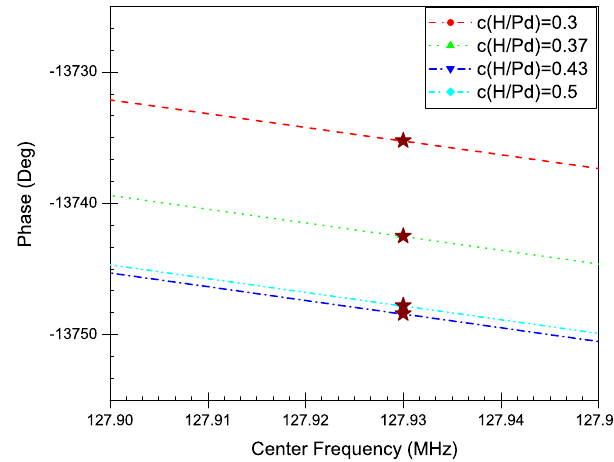
Figure 8. Phase Profiles for the concentration range 0.3-0.5 a.f. The ( (cid:144) ) sign illustrates the phase value at the center frequency.